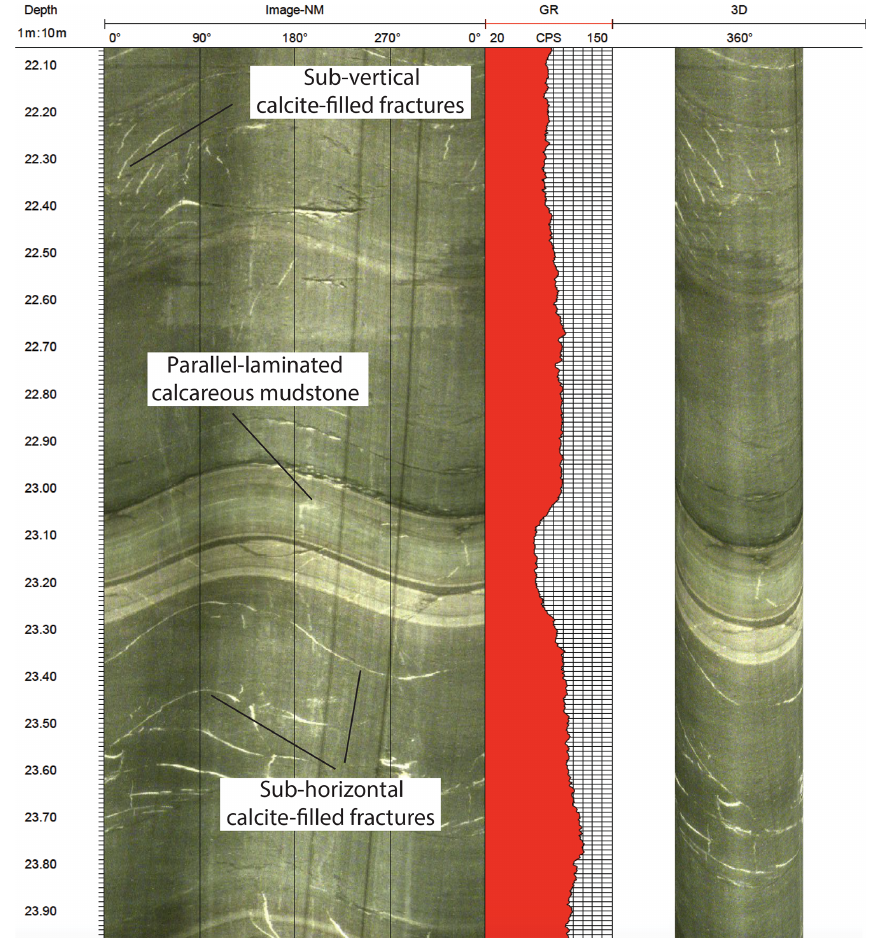
Figure 3. Example of Gajum borehole wall image recorded with a QL40-OBI optical televiewer. From left to right: borehole depth, 360 ◦ continuous upwrapped digital image of the borehole wall, total natural gamma ray, 3-D log visualization reproducing a virtual core of the